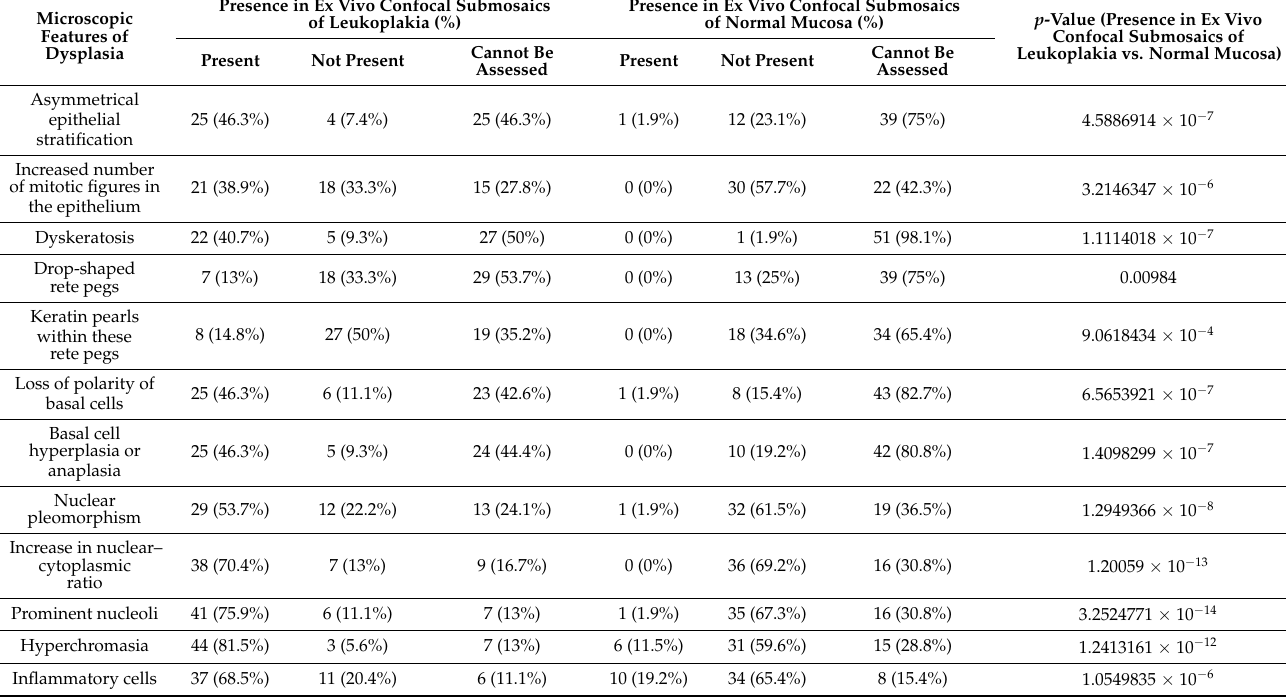
Table 3. Microscopic features of dysplasia in ex vivo FCM pictures of leukoplakia (N = 54) and normal mucosa (N = 52). Microscopic Features of